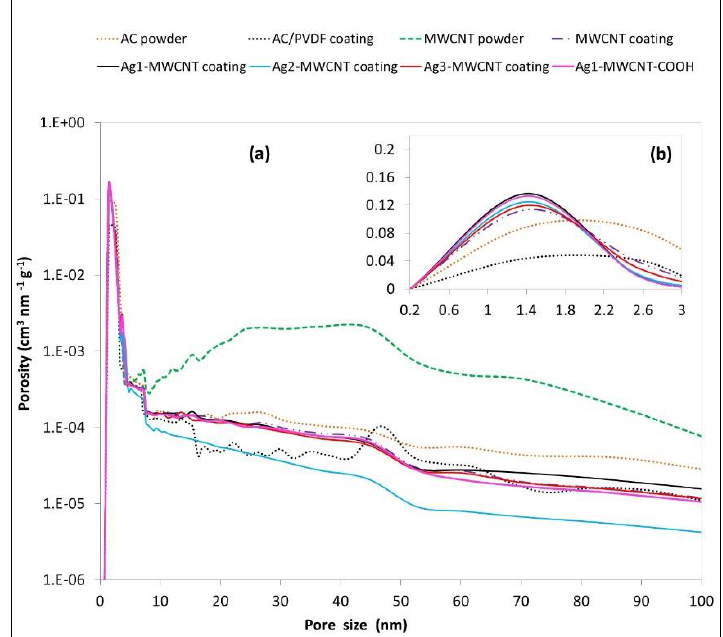
Figure 4. Pore size distribution of initial materials and composite coatings. The derived BET specific surface area values are as follows: AC powder: 926 m 2 ·g – 1 ; MWCNT powder: 145 m 2 ·g – 1 ; AC + 0.15 wt% MWCNT + 5 wt% PVDF coating: 707 m 2 ·g – 1 ; AC + 0.15 wt% Ag3-MWCNT + 5 wt% PVDF: 672 m 2 ·g – 1 ; 0.15 wt% Ag2-MWCNT + 5 wt% PVDF: 676 m 2 ·g – 1 ; 0.15 wt% Ag1-MWCNT + 5 wt% PVDF: